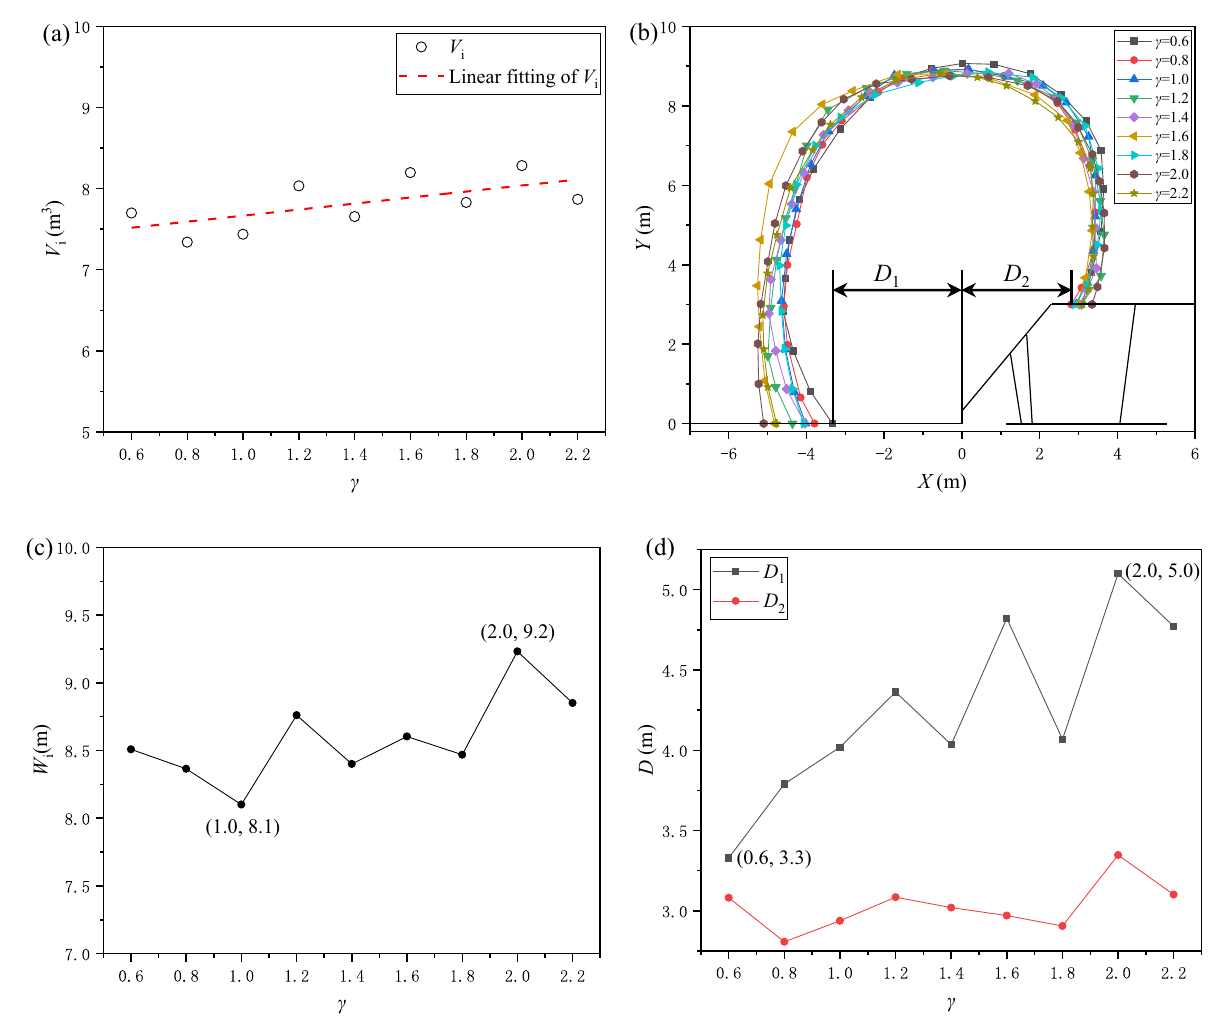
Fig. 7 Initial drawing body: a Volume; b Shape; c Width; d Variation of D